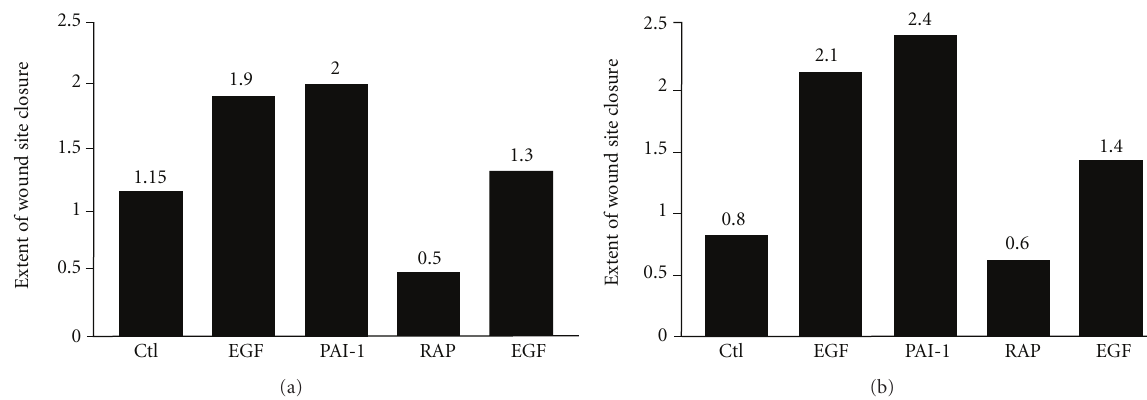
Figure 2: HaCaT II-4 cultures were grown to confluency, monolayers washed 2X with PBS and incubated in serum-free DMEM for 24 hours. Cultures were scrape-wounded with a P1000 pipette tip using a constant-pressure press, washed 3X to remove liberated cells, and returned to serum-free medium without (control) or with the following additives: EGF (10ng/mL), PAI-1 (40mM), RAP (5 μ g/mL), or the combination RAP (5 μ g/mL) + EGF (10ng/mL). Initial wound sizes were measured with a calibrated ocular grid at multiple marked sites; 24 hours later, the injury sites were remeasured at the identical marked regions used to calibrate the initial denuded area. The extent of wound site closure (motility index = grid distance migrated) was plotted on the y -axis for each condition; shown are data from 2 representative experiments. PAI-1 stimulated cell migration to the same extent as EGF. Ctl: control unstimulated cultures.